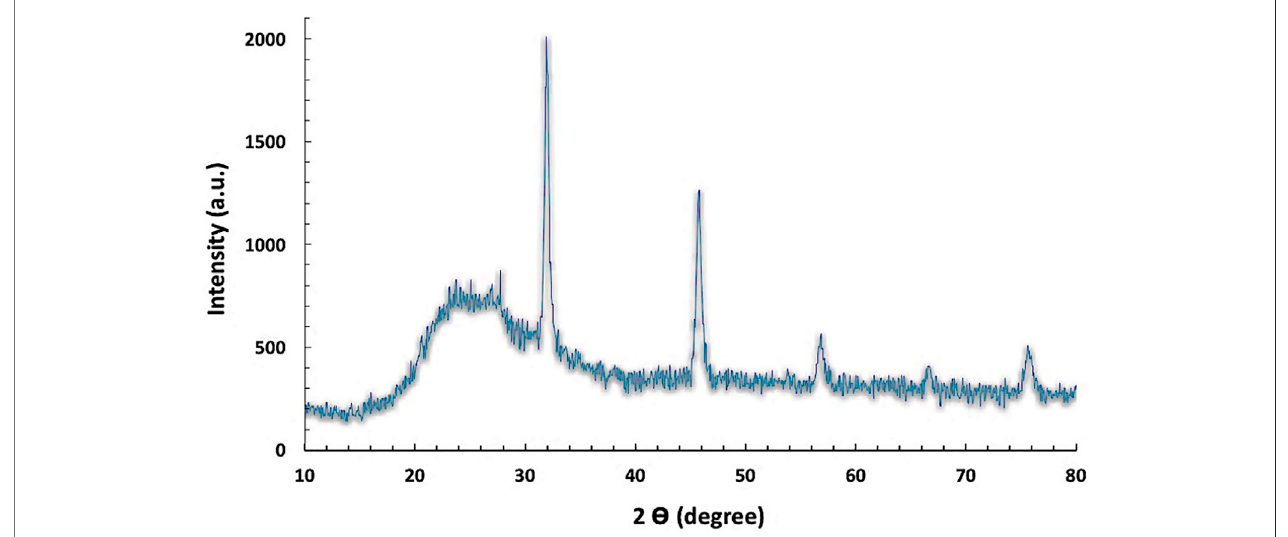
FIGURE 1 | XRD pattern of the investigated silica